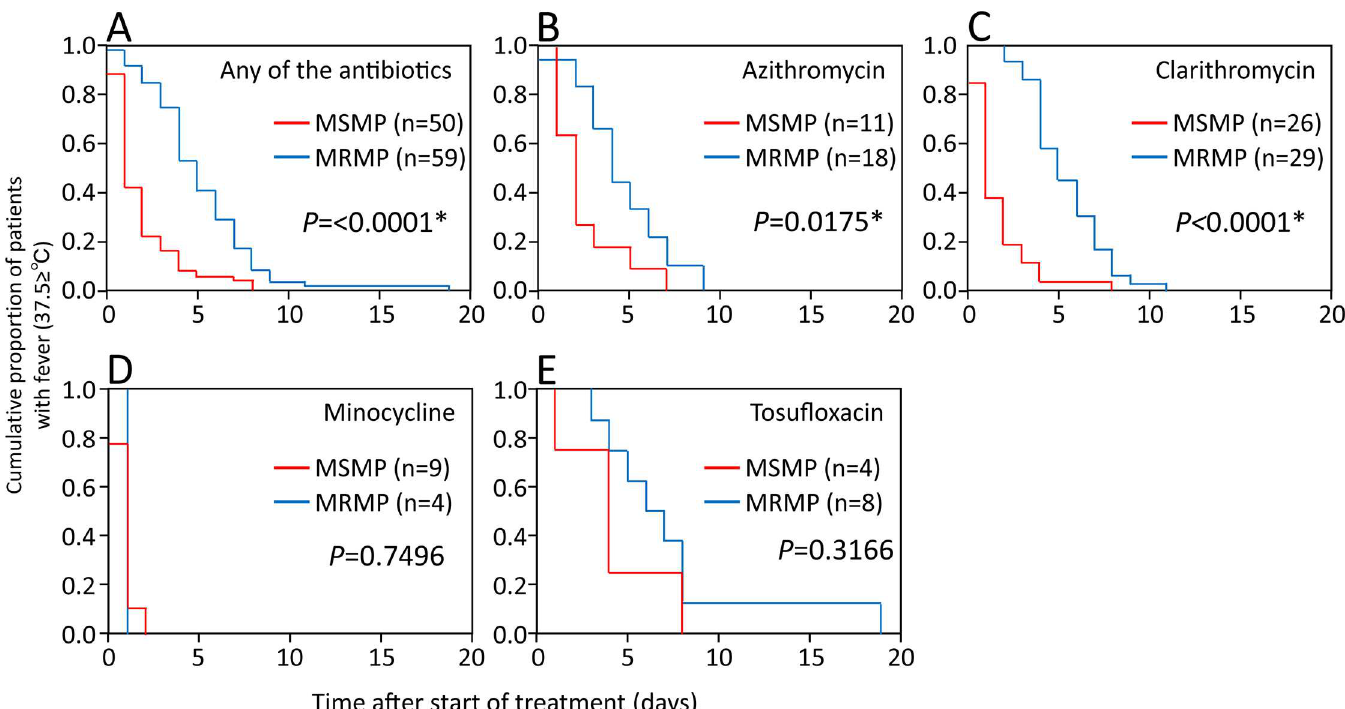
Fig 2. Differences between fever durations in the MRMP and MSMP groups following commencement of treatment with azithromycin, clarithromycin, minocycline and tosufloxacin. Kaplan–Meier curves showinga comparisonof times taken for body temperature to return to < 37.5˚C amongpatients infected with MRMP and patients infected with MSMP who were treated with (A) any of the antibiotics (log-ranktest, P < 0.0001),(B) azithromycin (log-ranktest, P = 0.0175),(C) clarithromycin (log-ranktest, P < 0.0001),(D) minocycline(log-ranktest, P = 0.7496)and (E) tosufloxacin (log- rank test, P =